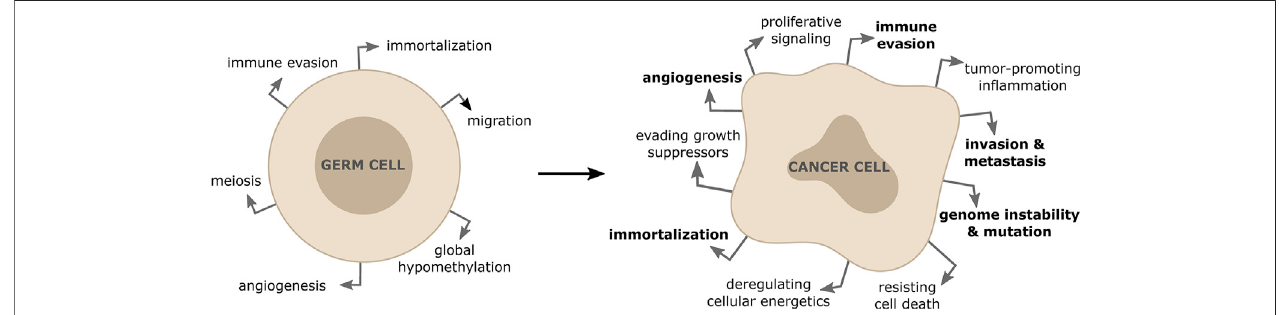
FIGURE1| Activationofmeioticgenesinsomaticcellscontributetopropertiesoftumor formationandprogression.There-expression ofmeioticgenesinsomatic cancer cells is responsible for driving some of the hallmarks of cancers (shown in